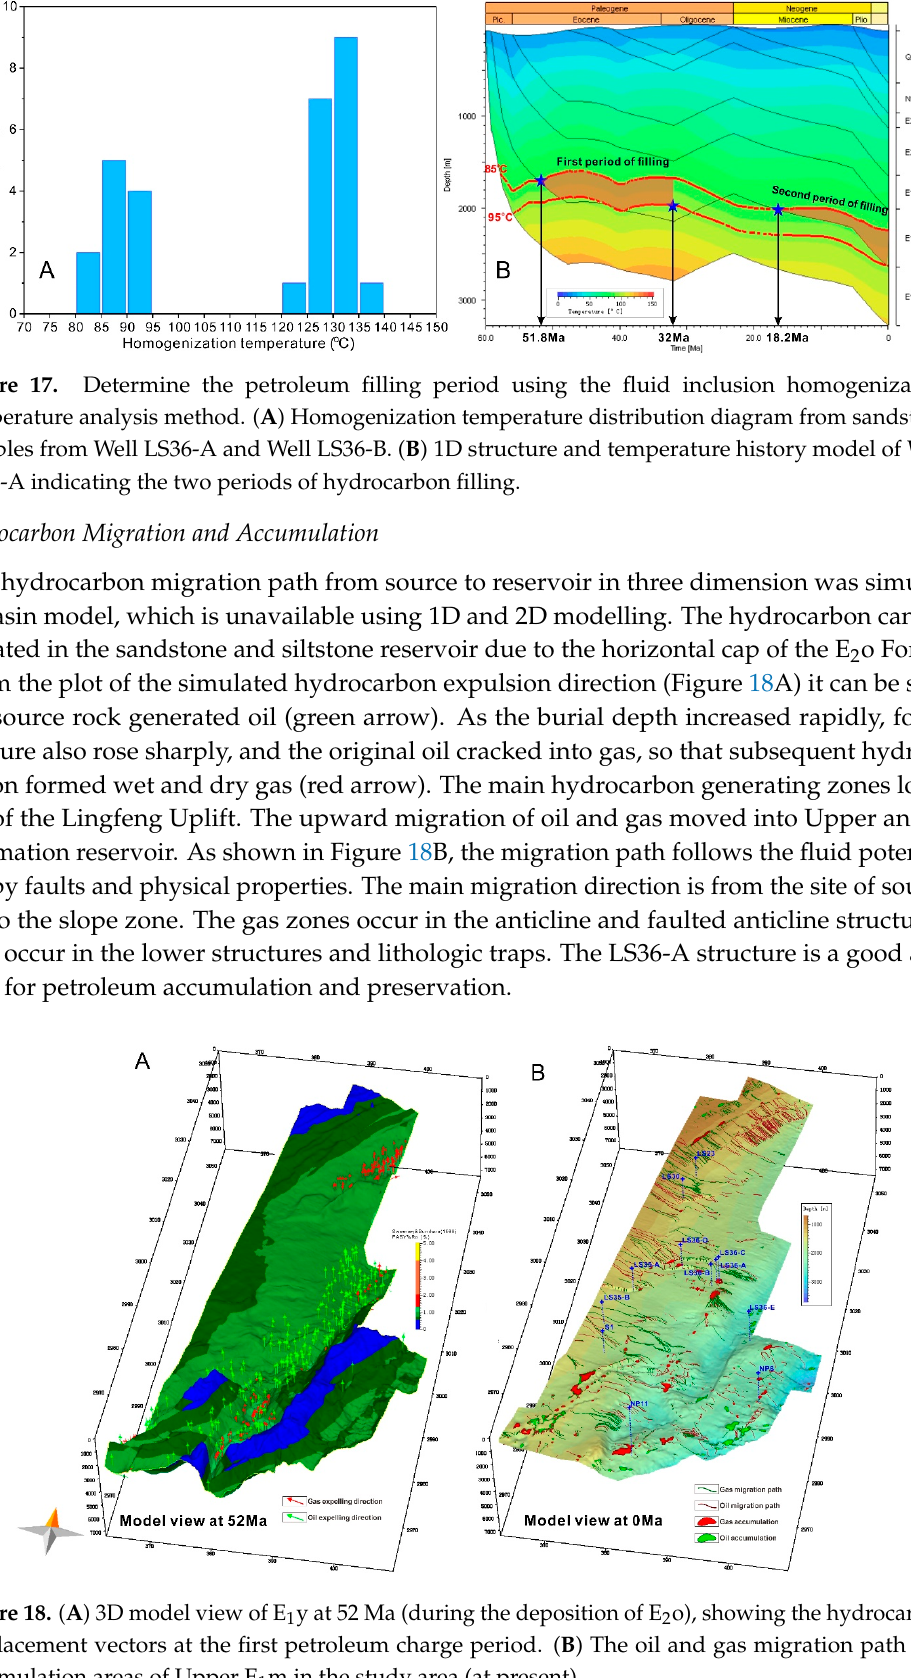
Energies 2019 , 12 , x 16 of 20 Figure 16. ( A ) Maturity evolution for each source rock according to vitrinite reflectance (solid lines) and transformation ratio (dash lines). ( B ) The bulk generation mass evolution of three main source rock: E 1 y, Lower E 1 l and Upper E 1 l (solid lines), and the petroleum filling saturation history in the Upper E 1 m for Well LS36-A (dash line). 5. Discussion 5.1. Hydrocarbon Generation and Expulsion The main hydrocarbon generation period can be figured out by the generation rate and mass of the source rocks. As we can see, the generation mass has a positive relation with the transformation